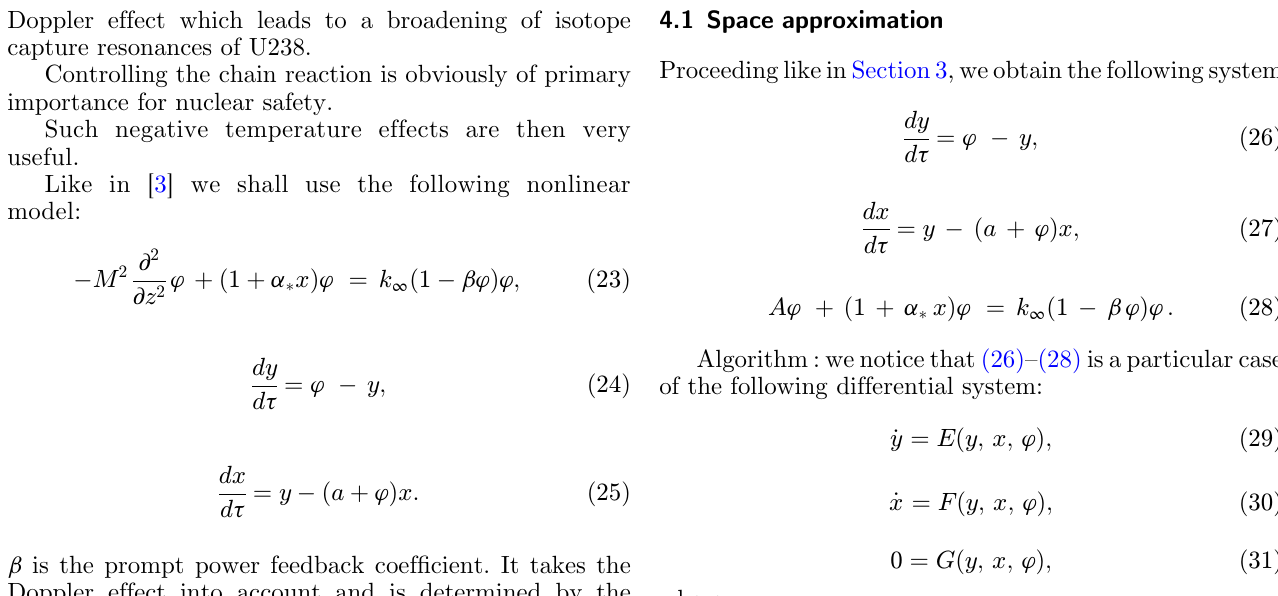
Fig. 5. One group vs